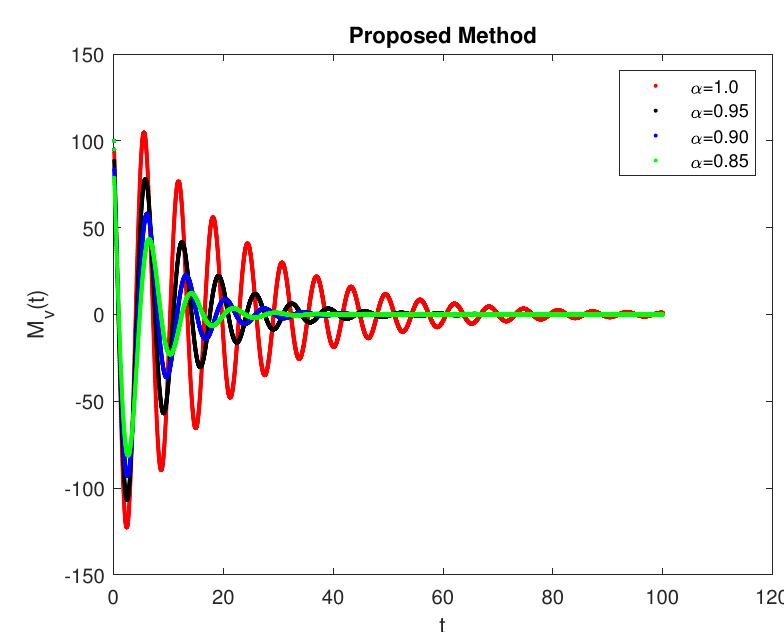
Figure 20: Numerical simulations for τ = 1 for Caputo-Fabrizio